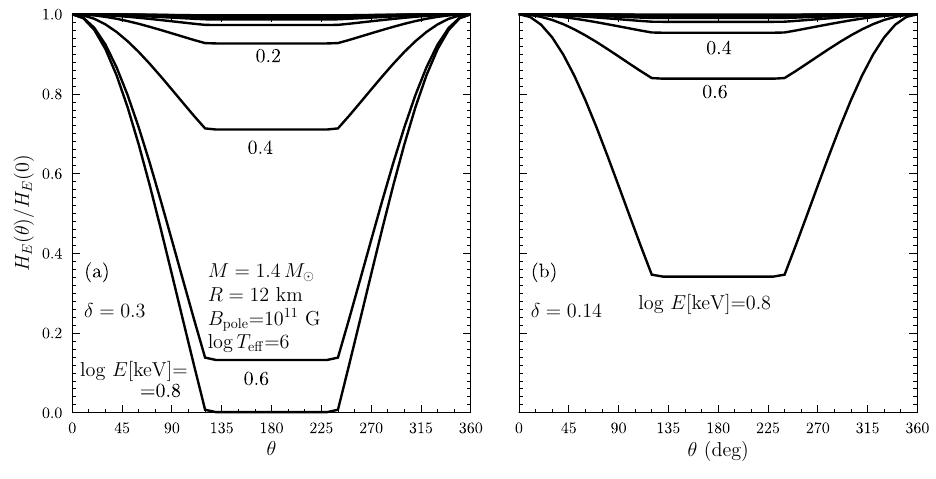
Figure 10. Same as in Figure 9 but for B pole = 10 11